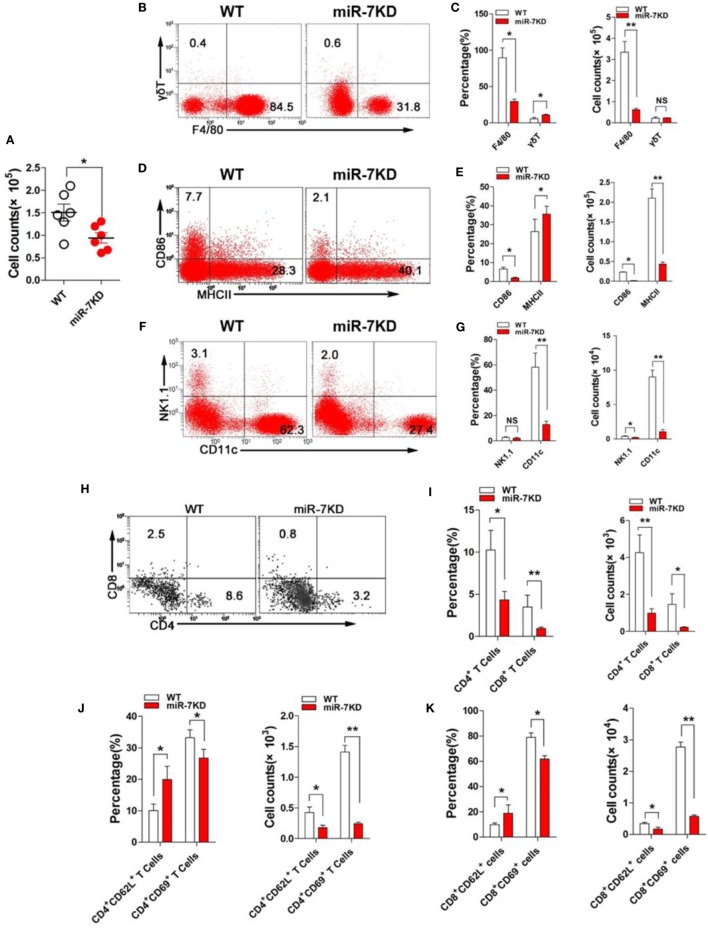
miR-7 deficiency altered the immune cell composition in BAL of mice from ALI. FVB/N6 mice (WT, n = 6) and miR-7KD mice (n = 6) were administered with i.p. 10 mg/kg LPS, respectively. After 48 h, (A) the total numbers of BAL cells were calculated. (B) The proportion of F4/80+ Mφ and γδ+ T cells were analyzed by FCM. The percentage and the absolute number of cells were calculated, respectively (C). (D) The expression of CD86 and MHC-II on F4/80+ Mφ were analyzed by FCM. The percentage and the absolute number of cells were calculated, respectively (E). (F) The proportion of CD11c+ dendritic cells and NK1.1+ T cells were analyzed by FCM. The percentage and the absolute number of cells were calculated, respectively (G). (H) The proportion of CD4+ T cells and CD8+ T cells were analyzed by FCM. The percentage and the absolute number of cells were calculated, respectively (I). (J) The expression of CD62L and CD69 on CD4+ T cells were analyzed by FCM. And, the percentage and the absolute number of cells were also calculated, respectively. (K) The expression of CD62L and CD69 on CD8+ T cells were analyzed by FCM. And, the percentage and the absolute number of cells were also calculated, respectively. Representative data of three independent experiments were shown. *p < 0.05, **p < 0.01.